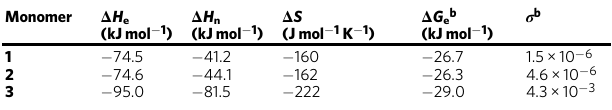
Table 1 Thermodynamic parameters of the supramolecular homopolymerization of 1 – 3 obtained by temperature- dependent spectroscopic data a